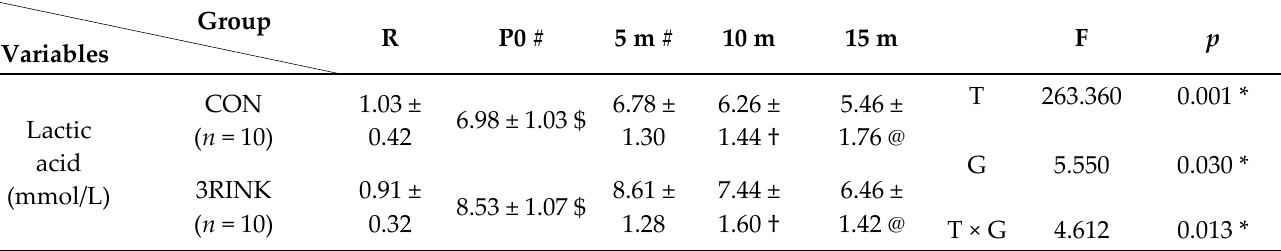
Figure 4. Changes in recovery ability according to the timing of fluid intake. Data represent the mean and SEM ( n = 10 per group). Statistical significance for variance was denoted as * p < 0.05, and differences between groups for change over time were denoted as # p < 0.05. R = Rest, P0 = Right after exercise, 5 m = 5 min after exercise, 10 m = 10 min after exercise, 15 m = 15 min after exercise. Table 4. Changes in recovery ability.